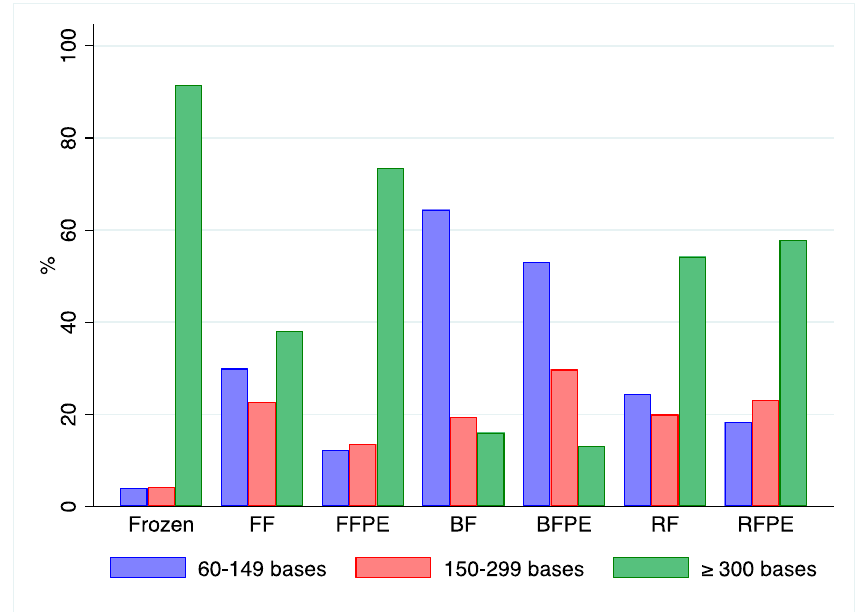
Figure 5. Analysis of RNA fragments length: Bar plots representing the distribution of 60–149, 150–299 bases and equal to or over 300 bases fragments by BioAnalyzer method in fresh frozen, FF formalin-fixed, FFPE formalin-fixed and paraffin-embedded, BF Bouin’s solution fixed, BFPE Bouin fixed and paraffin-embedded, RF RCL2 fixed and RFPE RCL2 fixed and paraffin-embedded mouse livers. A higher fragmentation is observed in Bouin’s solution fixed samples (BF and BFPE, respectively).